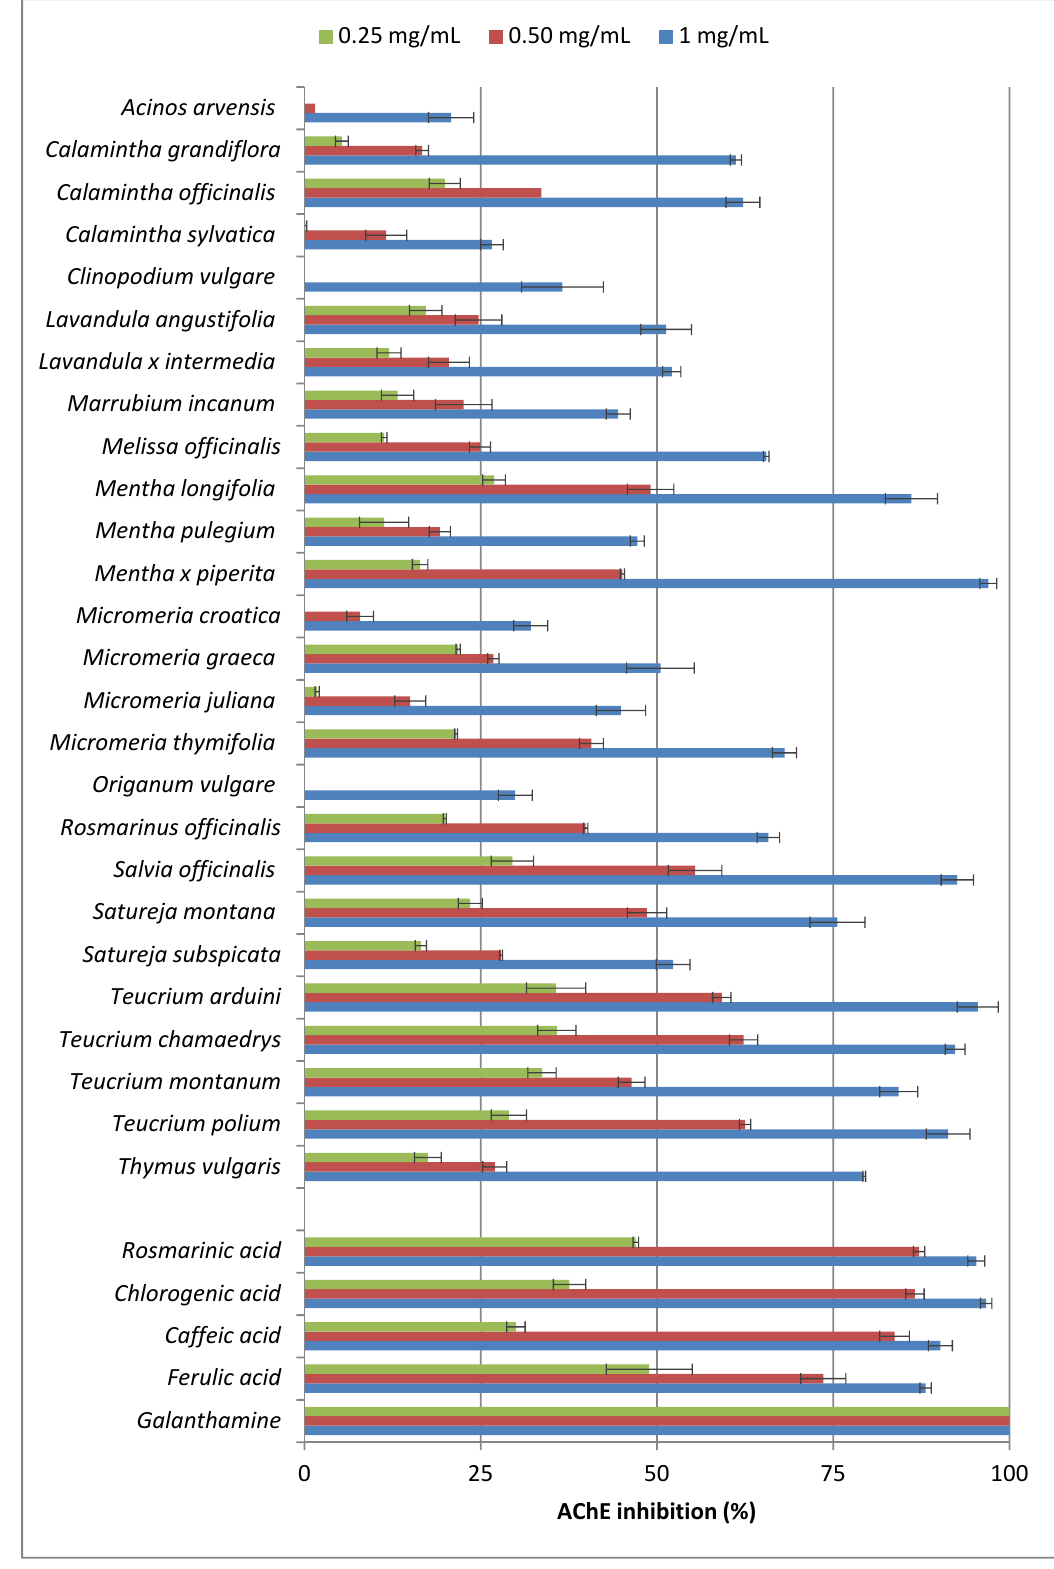
Figure 1. Acetylcholinesterase (AChE) inhibitory activities of the ethanolic extracts of selected Lamiaceae species and their phenolic acid